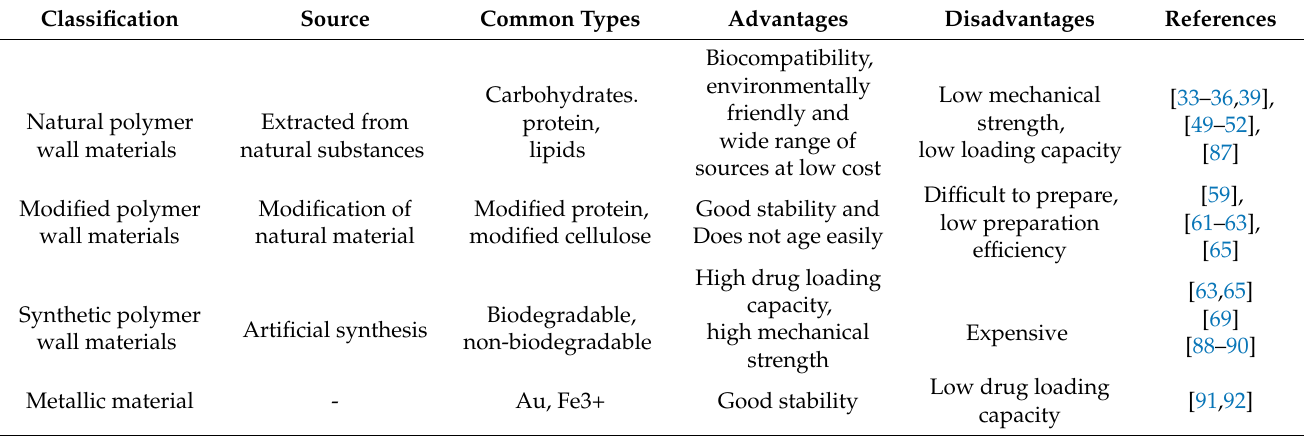
Table 1. Classification of wall materials of peptides microcapsules.